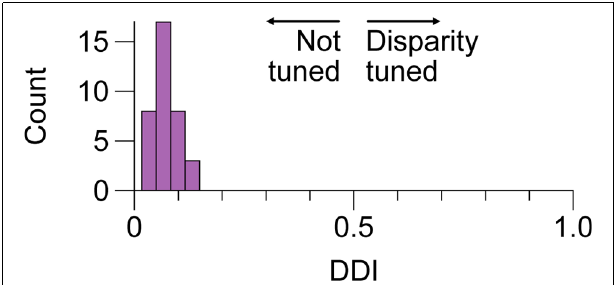
FIGURE 4 | No tuning for positional disparity in LGN cells of the M and P layers. Distribution of disparity discrimination indices (DDI) for a sample of 36 LGN cells included in this study. Higher values indicate more tuning. We did not observe evidence of modulation by disparity in any of the cells; P and M cell DDIs were not distributed differently and are aggregated here. LGN, lateral geniculate nucleus.